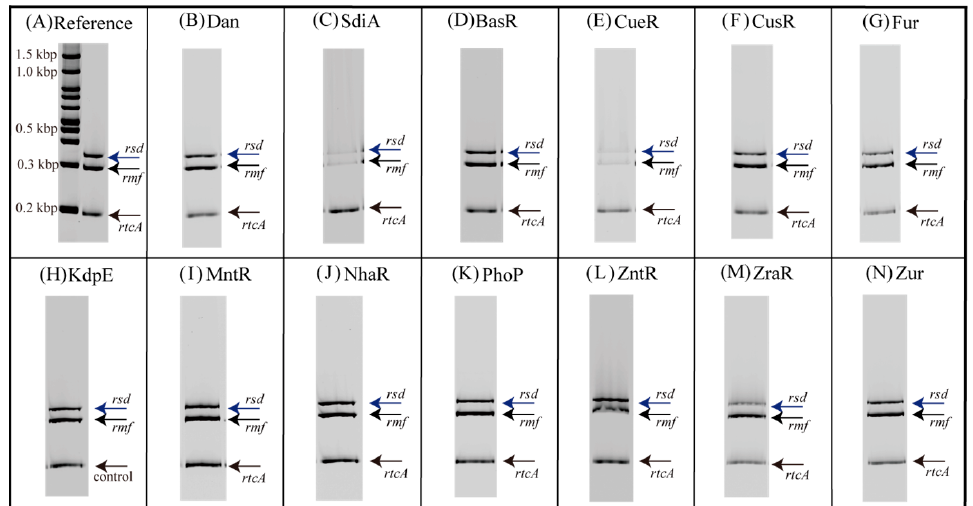
Figure 1. Promoter-specific transcription factor (TF) screening for metal-responsive TFs with rsd and rmf promoter-binding activity. Three fluorescein-4-isothiocyanate-labeled DNA probes (0.5 pmol each; specific for the 300 bp-long rsd promoter, the 256 bp-long rmf promoter, or the 193 bp-long rtcA internal DNA as a reference) were each mixed with 20 pmol of purified TFs (Figure S1) in 10 µL of DNA-binding buffer and incubated at 37 °C for 20 min. The DNA–protein mixtures were then directly subjected to PAGE to detect DNA–protein complexes. ( A ) No TF was added to the samples. ( B ) Dan, known not to bind either the rsd or rmf promoters, was added. ( C ) SdiA, known to bind both rsd and rmf promoters, was added. ( D – N ) Metal-responsive TFs were added.